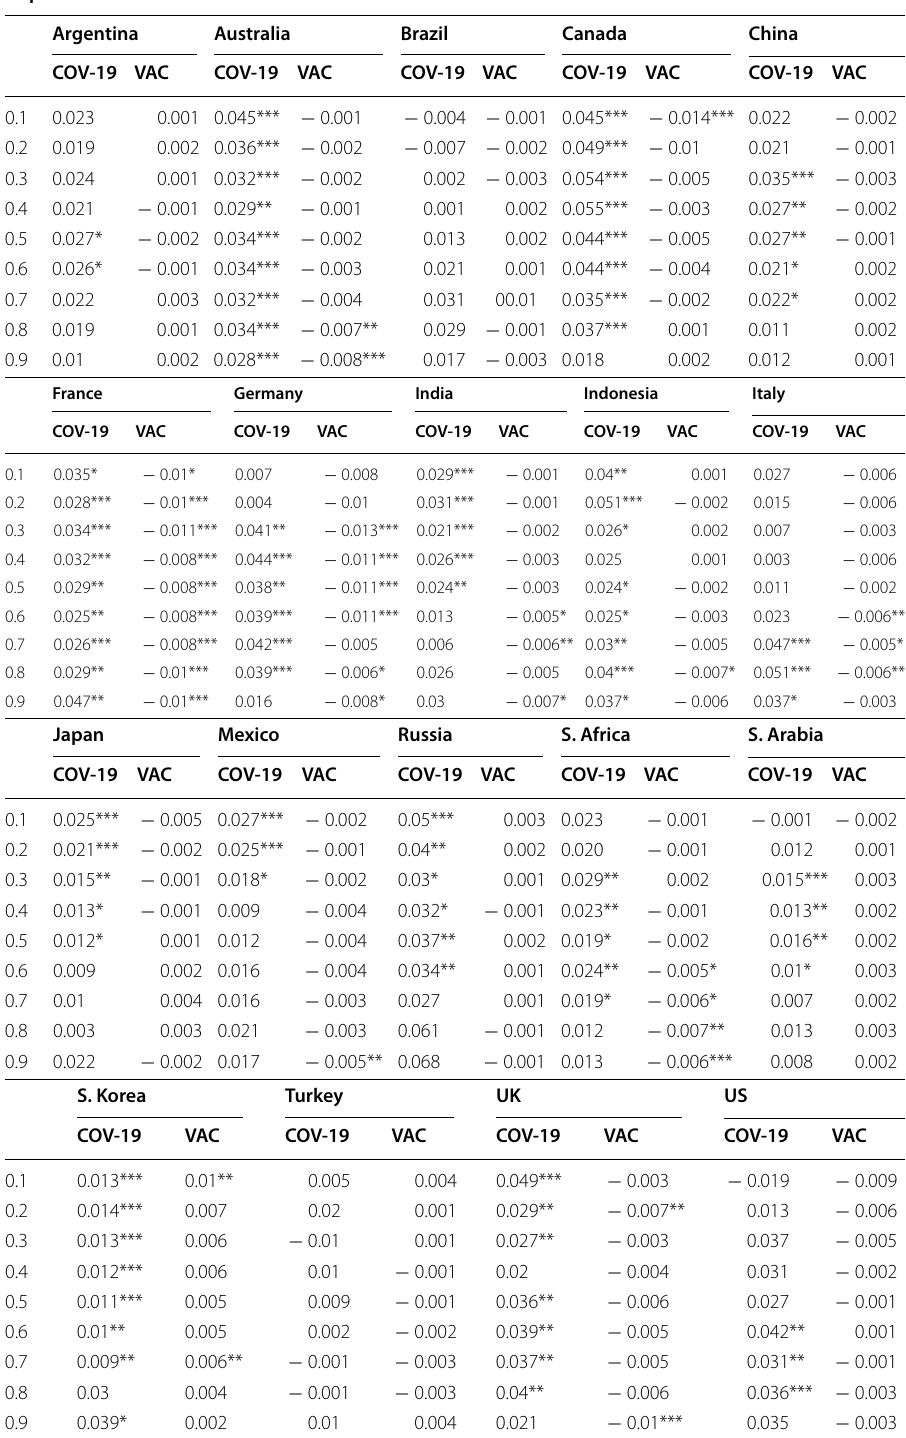
Table 11 Country quantile regression model results for volatility Dependent variable: